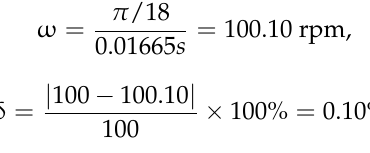
Figure 4. The 100 rpm oscilloscope waveform.